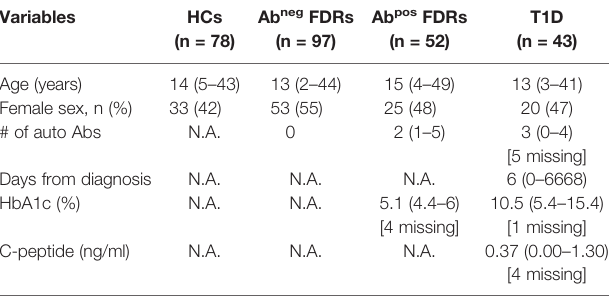
TABLE 2 | Characteristics of subjects enrolled for genetic studies.